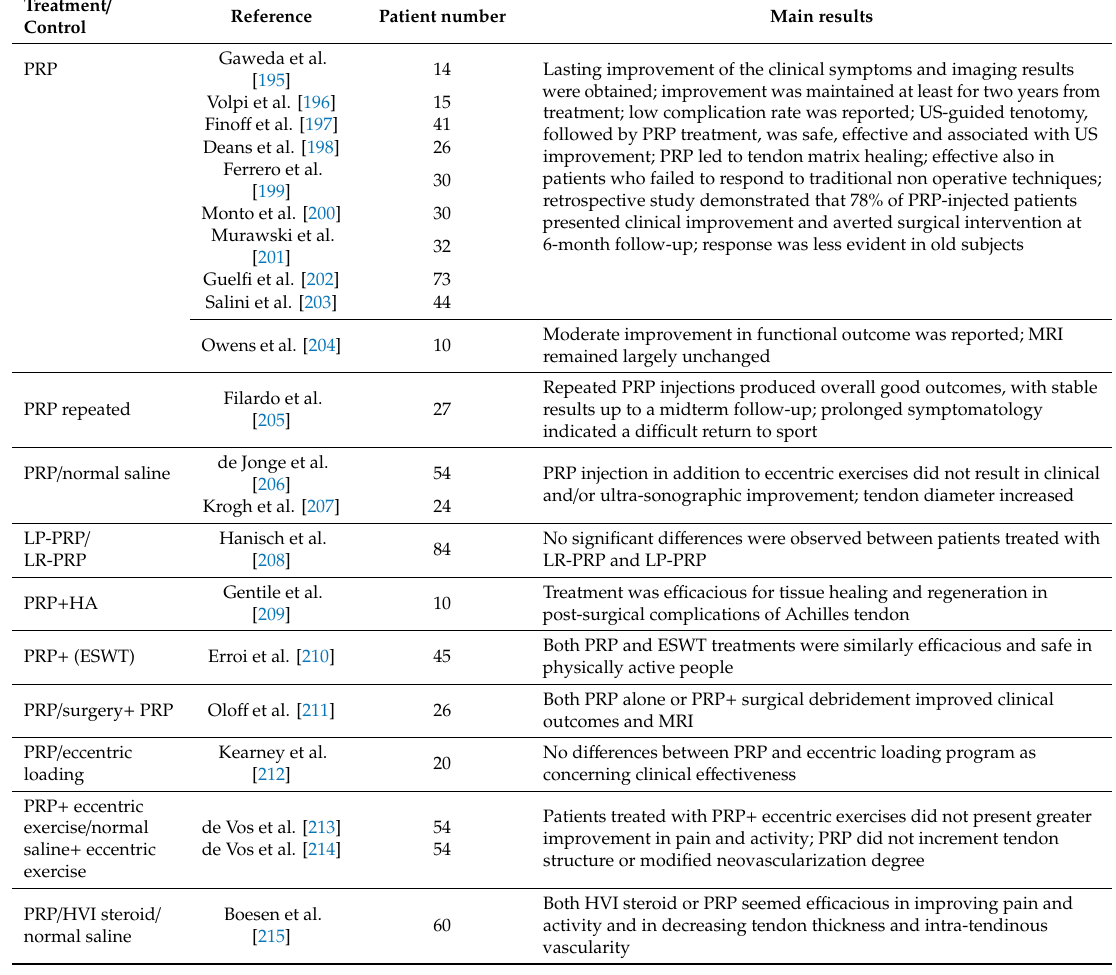
Table 5. Evidence of PRP treatment in Achilles tendinopathy (reported by year of study and grouped by